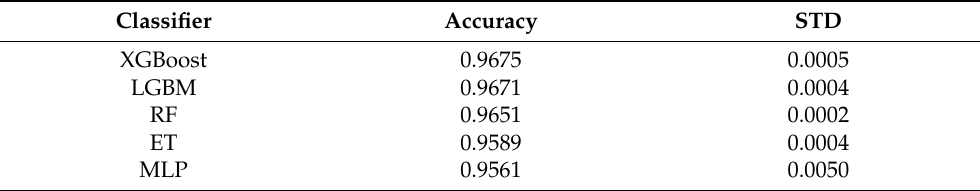
Table 1. Performance results among different algorithms on training data (Five-fold cross-validation).